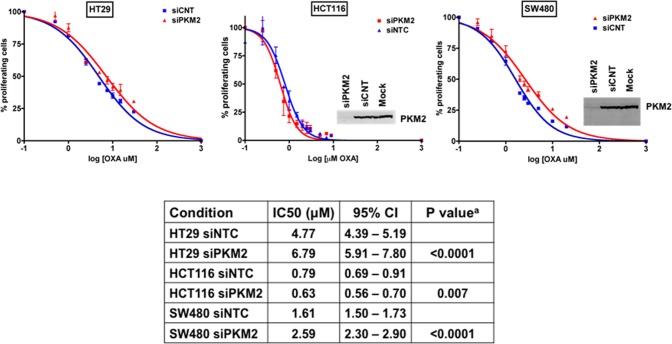
Effect of PKM2 silencing on OXA cytotoxicity in HT29, SW480 and HCT116 cells.Dose-response curves for HT29, SW480 and HCT116 cell lines after PKM2 gene silencing and OXA treatment at 0–140 μM and 0–32 μM for 24 hours. Curves represent the average values from at least three independent experiments. Cell proliferation was measured by MTT assay. Vertical bars in the graphics represent ± SD. Insets show PKM2 inmunoblotting after siRNA-directed inhibition. Specific IC50 values for oxaliplatin in all conditions are displayed in the table. IC50 values for Mock conditions (without transfection) were very similar to those of siNTC and are not shown. *p-values are result of comparison to the siNTC condition.